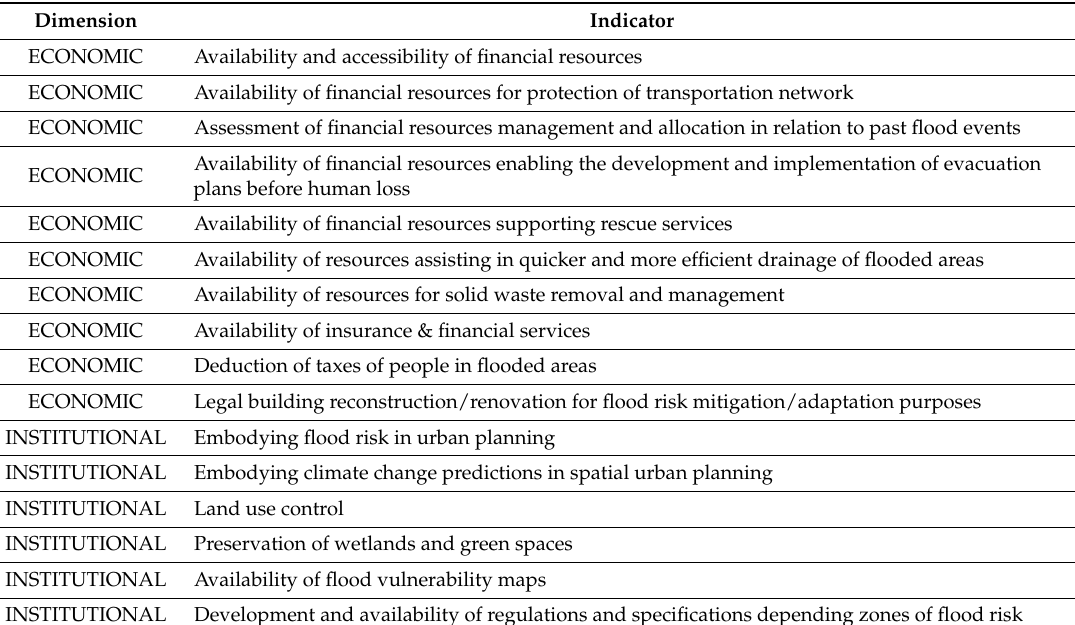
Table B1. List of indicators used in the FRI component per dimension.